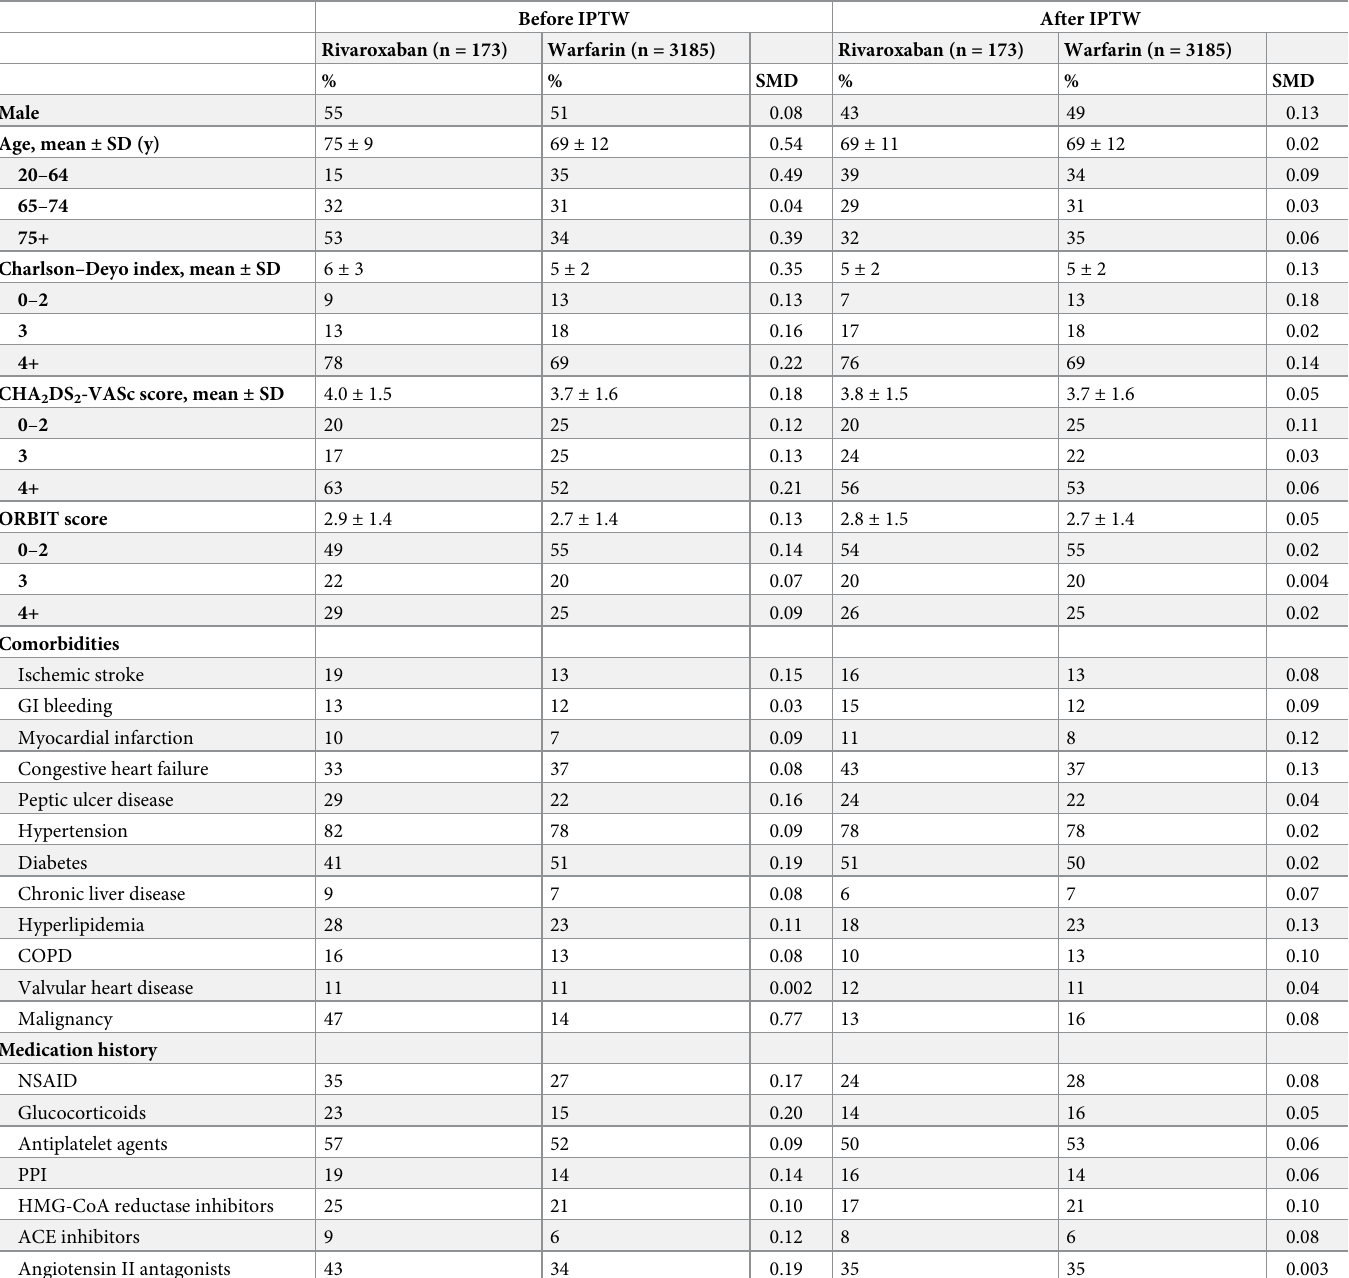
Table 1. Baseline characteristics of eligible patients received rivaroxaban and